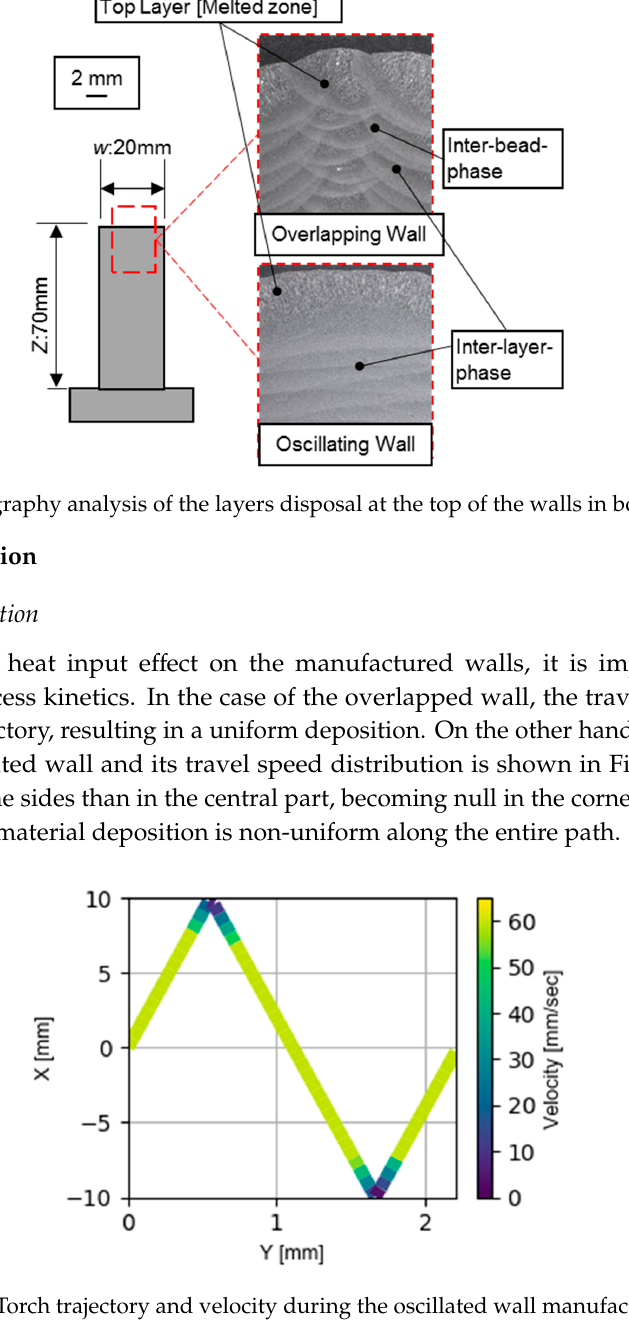
Figure 8. Torch trajectory and velocity during the oscillated wall manufacturing.